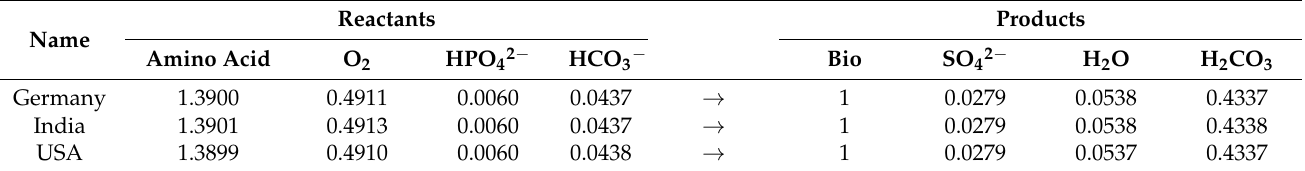
Table 2. Stoichiometric coefficients for the biosynthesis reactions of the nucleocapsids of the